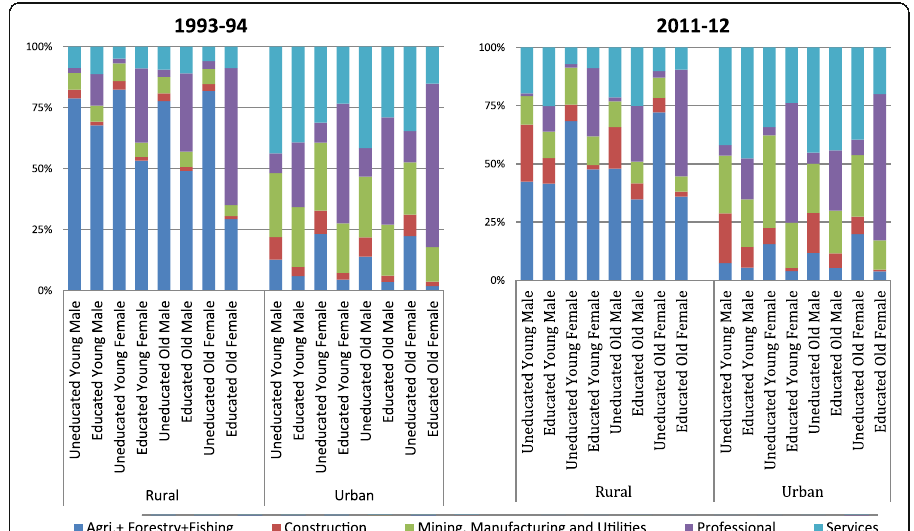
Fig. 6 Industry share of employment by demographic